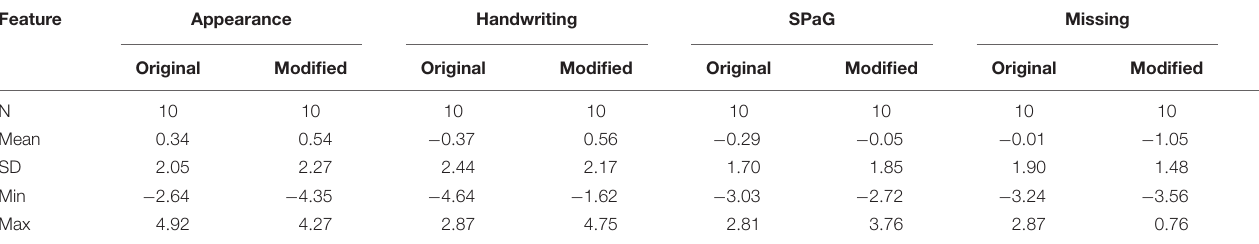
TABLE 2 | Descriptive statistics of the comparative judgment (CJ) measures for each of the four features. Feature